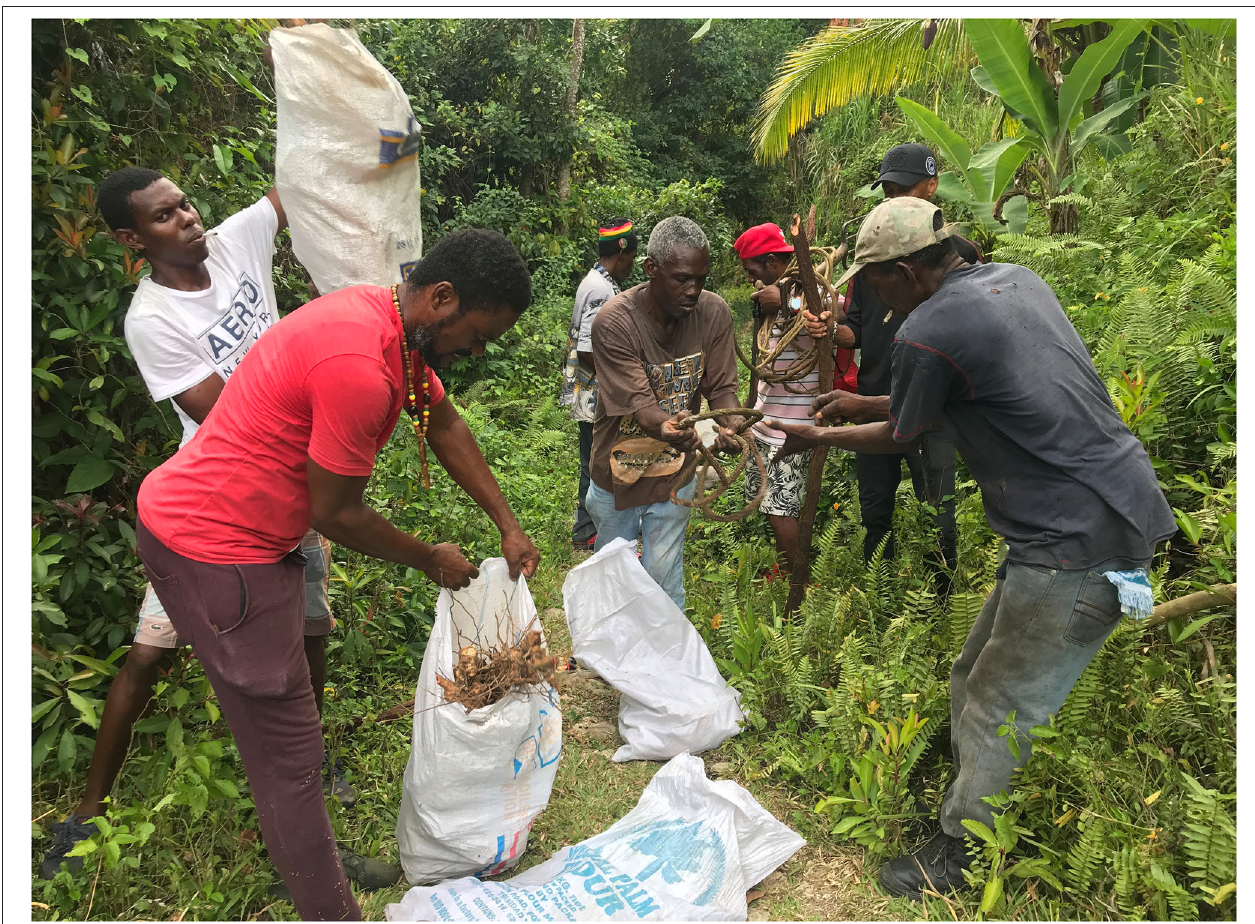
FIGURE 2 | Collecting roots and lianas (called “wiss”) of various wild-harvested plant species to prepare root tonics in St. Thomas parish, at the fringes of the John Crow Mountains, 3 days before the full moon (photo credit